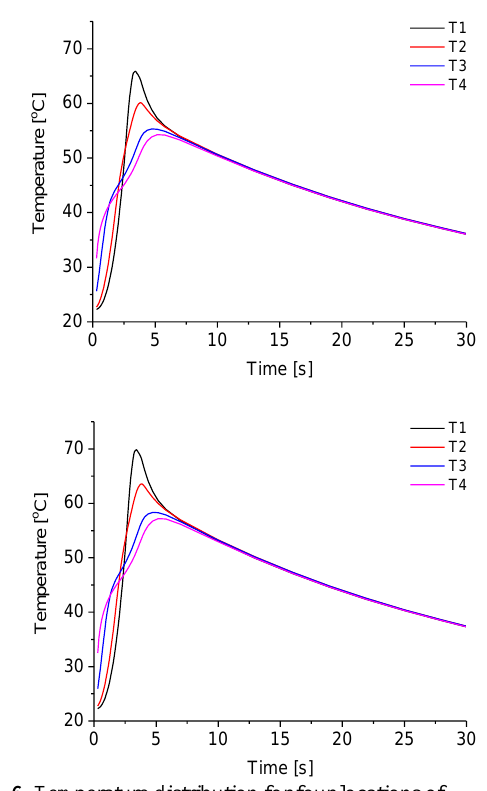
Fig. 6. Temperature distribution for four locations of measuring points a) v c = 214.8 [m/min], b) v c = 315.4